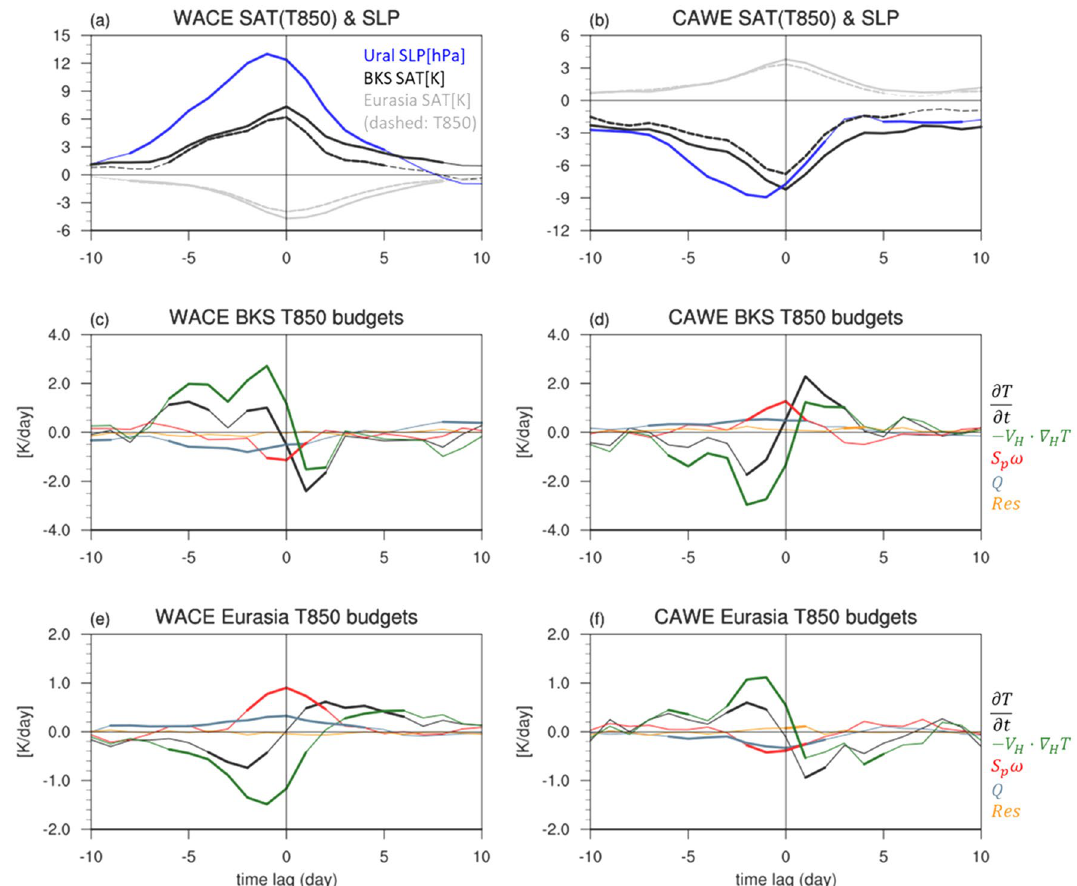
Figure 5. ( a ) Time evolution of lead-lag composites of BKS (black) and Eurasian (gray) SAT (solid line), T850 (dashed line), and Ural SLP (blue) for the WACE cases. Lead-lag composites of temperature tendency and anomalous budget terms in ( c ) BKS and ( e ) Eurasia. ( b , d , f ) Same as in ( a , c , e ) but for CAWE cases. The statistically significant values at the 95% confidence level are bolded. Figures were created with the